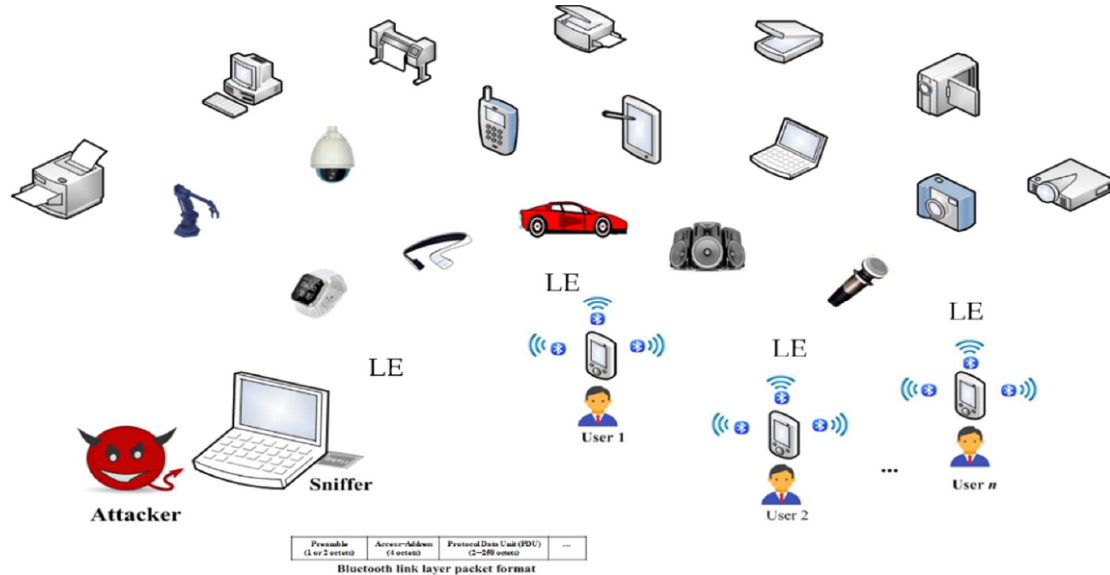
Figure 1. Privacy analysis of Bluetooth personal communication.